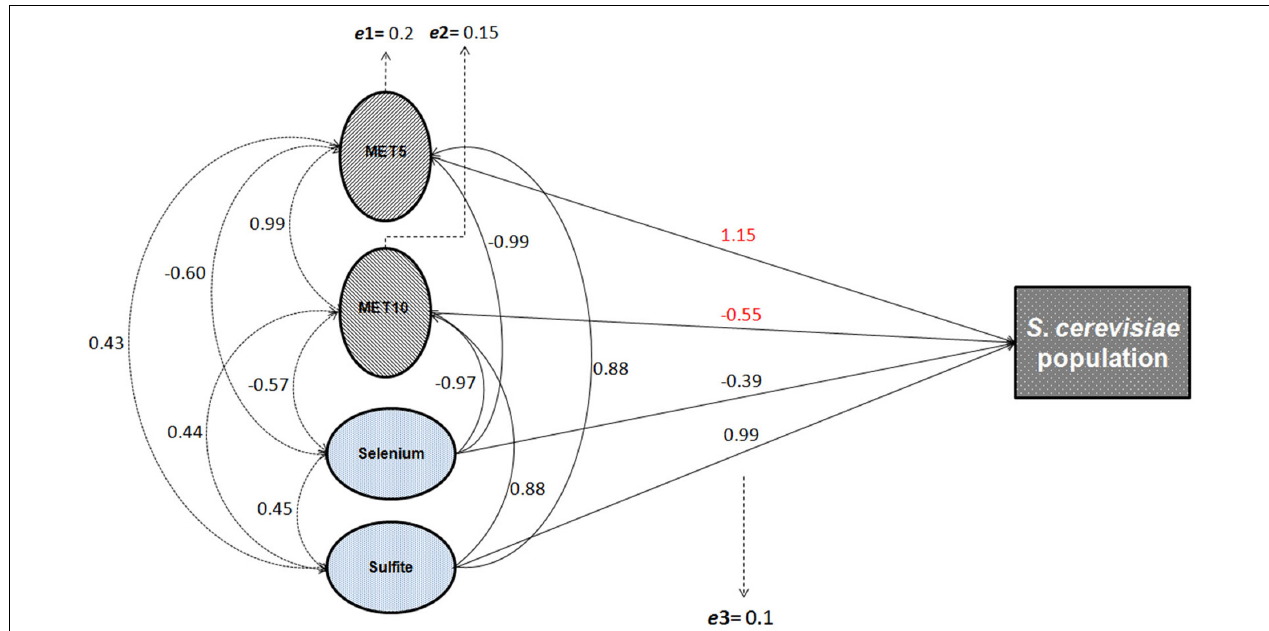
FIGURE 4 | General diagram of the possible relationships between abiotic and gene expression variables and the population growth of S. cerevisiae . Solid arrows show the direct effects of independent variables on the dependent variables ( S. cerevisiae population growth, gene expression, and sulfite reductase activity). Dashed arrows show the indirect effects, i.e., the correlation coefficients among variables. The correlation and path coefficients for these relationships are also shown in the Supplementary Tables S1 , S2 ; e 1: residual variable of the model assessing the direct effect of sulfite and selenium on MET5 expression; e2: residual variable of the model assessing the direct effect of sulfite and selenium on MET10 expression; and e3: residual variable of the model assessing the direct effect of sulfite, selenium, and the expression of MET5 and MET10 on yeast population